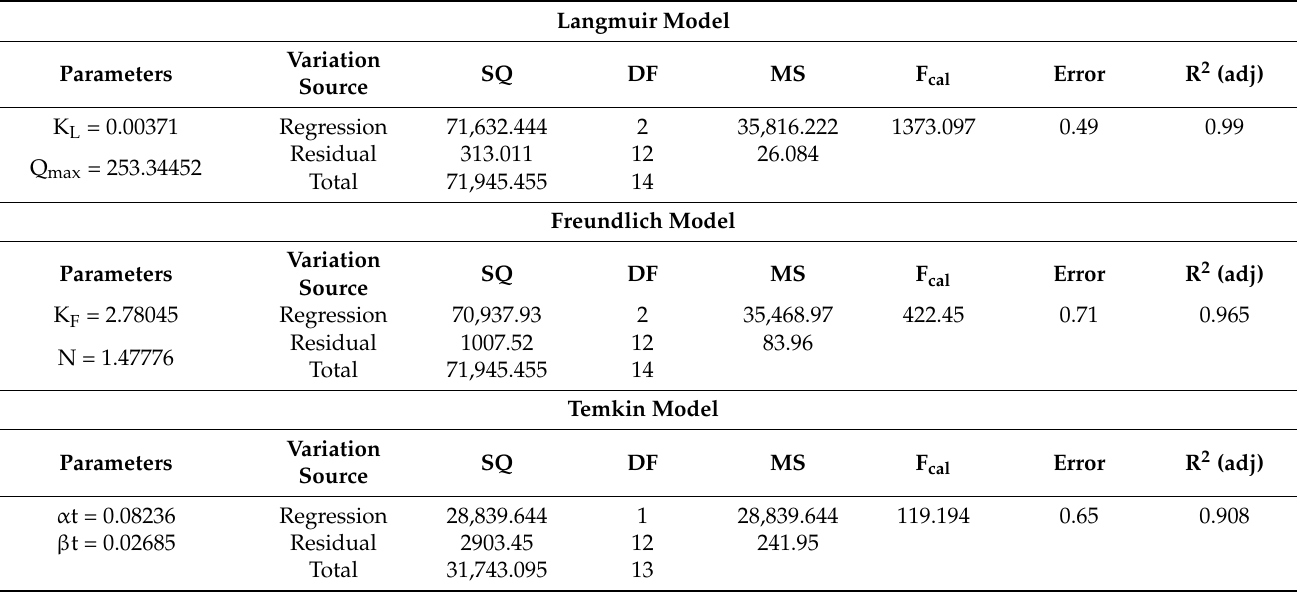
Table 11. Parameters and ANOVA obtained experimental data of SD adsorption in organo- functionalized sample fitting to the isotherm models of Langmuir, Freundlich and Temkin. Langmuir